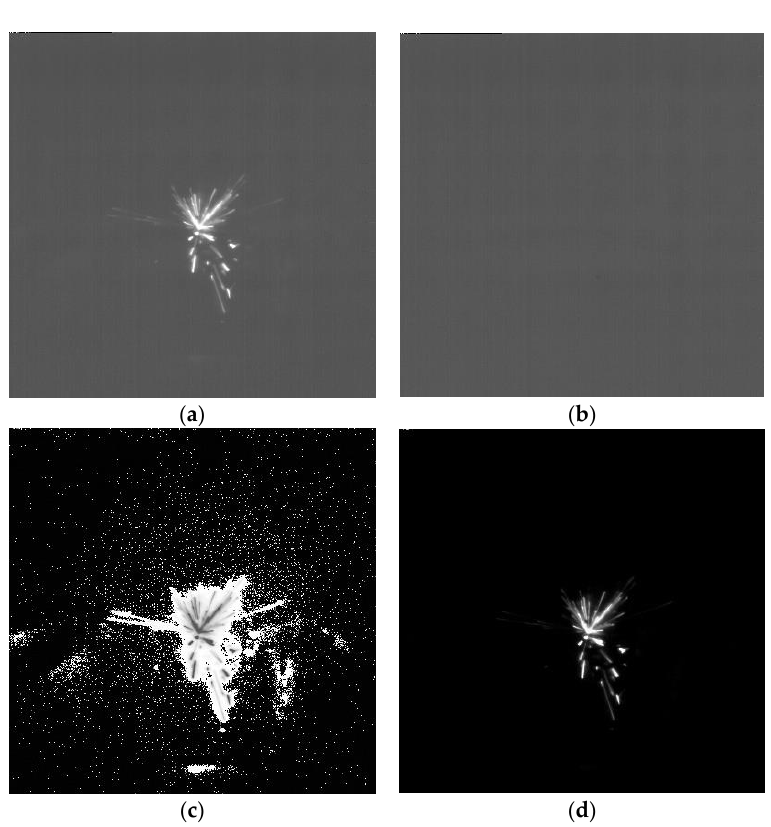
Figure 10. Image filter process ( a – d ): ( a ) original ( Y t ); ( b ) background (Y 0 ); ( c ) difference (Y bd ); ( d ) objective (X).